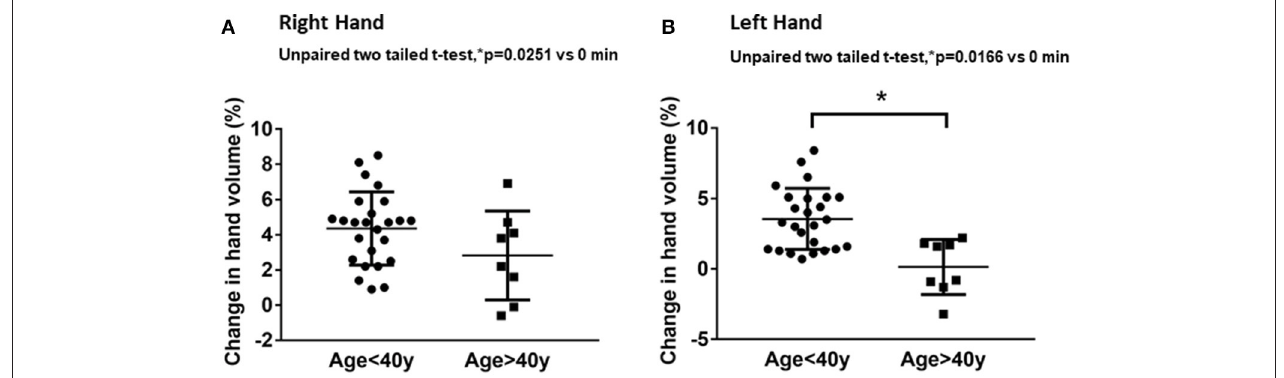
FIGURE 1 | Age-related effects on hand volume measurements. The data represent percentage changes in hand volume measured using a hand volumeter after 20min of hand immersion in water for the younger age group ( ≤ 40 years) and older age group ( > 40 years) in the right hand (A) and left hand (B) .Values are means ± SD. * p < 0.05 by two-tailed unpaired t -test, n = 40.